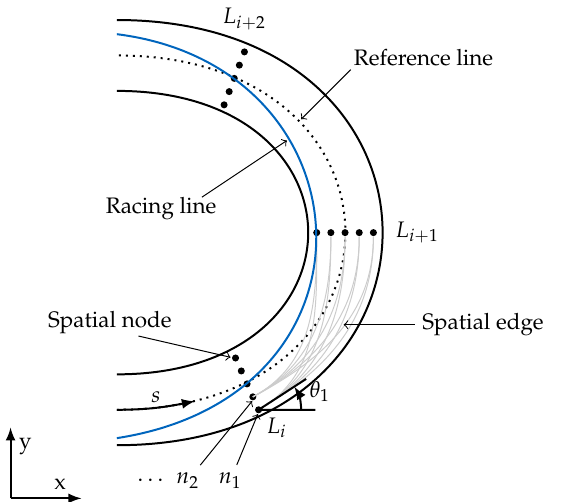
Figure 2. Spatial graph. The layers group spatial nodes. Spatial edges connect the spatial nodes and represent available paths.